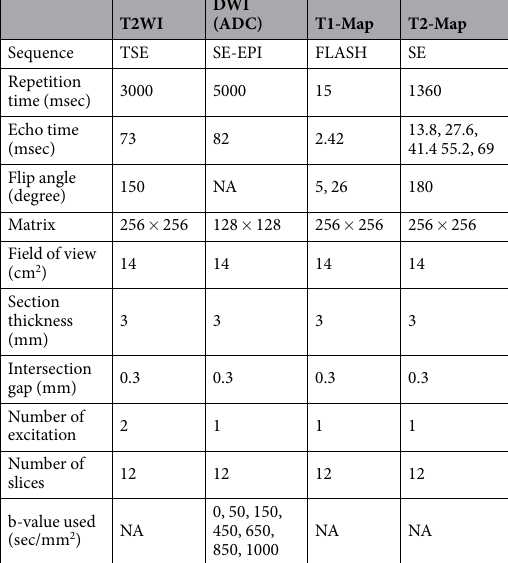
Table 2. Sequence parameters for renal 3.0-T MR imaging in rats with acute ischemic/reperfusion kidney injury. T2WI = T2-weighted image, DWI (ADC) = diffusion-weighted imaging (apparent diffusion coefficient), TSE = turbo spin-echo, EPI = echo-planar imaging, FLASH = Fast low angle shot, SE = spin-echo, TR = repetition time, TE = echo time, NA = not applicable.